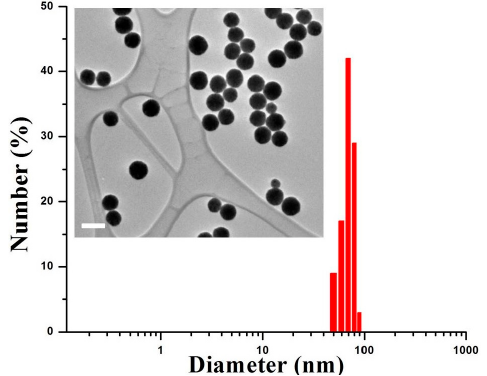
Figure 2. Measured hydrodynamic sizes of polyethylene glycol functionalized holmium oxide (PEG– Ho 2 O 3 ) NPs. Inset is a transmission electron microscopy (TEM) image of PEG–Ho 2 O 3 NPs (bar scale = 100 nm).